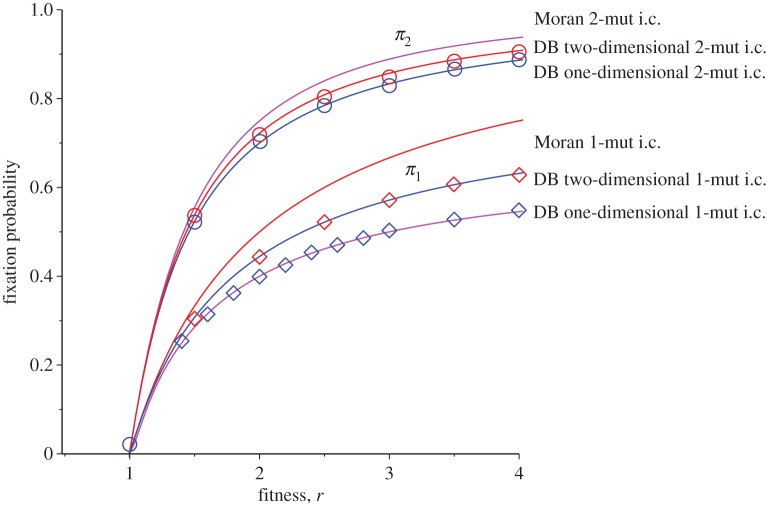
Comparison of fixation probability for two-mutant and one-mutant initial conditions for N=100 (one-dimensional DB) and N=20×20 square lattice (two-dimensional DB) as a function of division rate r. Solid lines are corresponding theoretical results. As can be seen the two-mutant results are closer to Moran formula, equation (6.5).